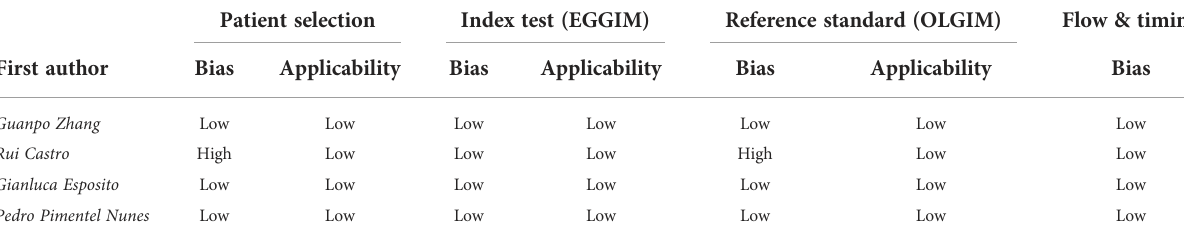
TABLE 2 Assessment of risk of bias and applicability concern for all included diagnostic studies.